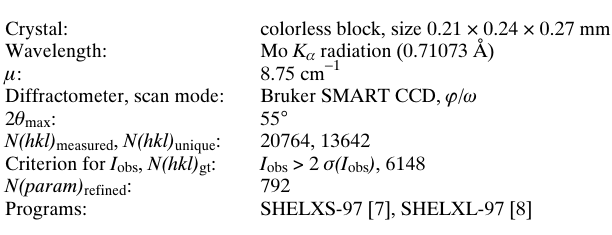
Table 1. Data collection and